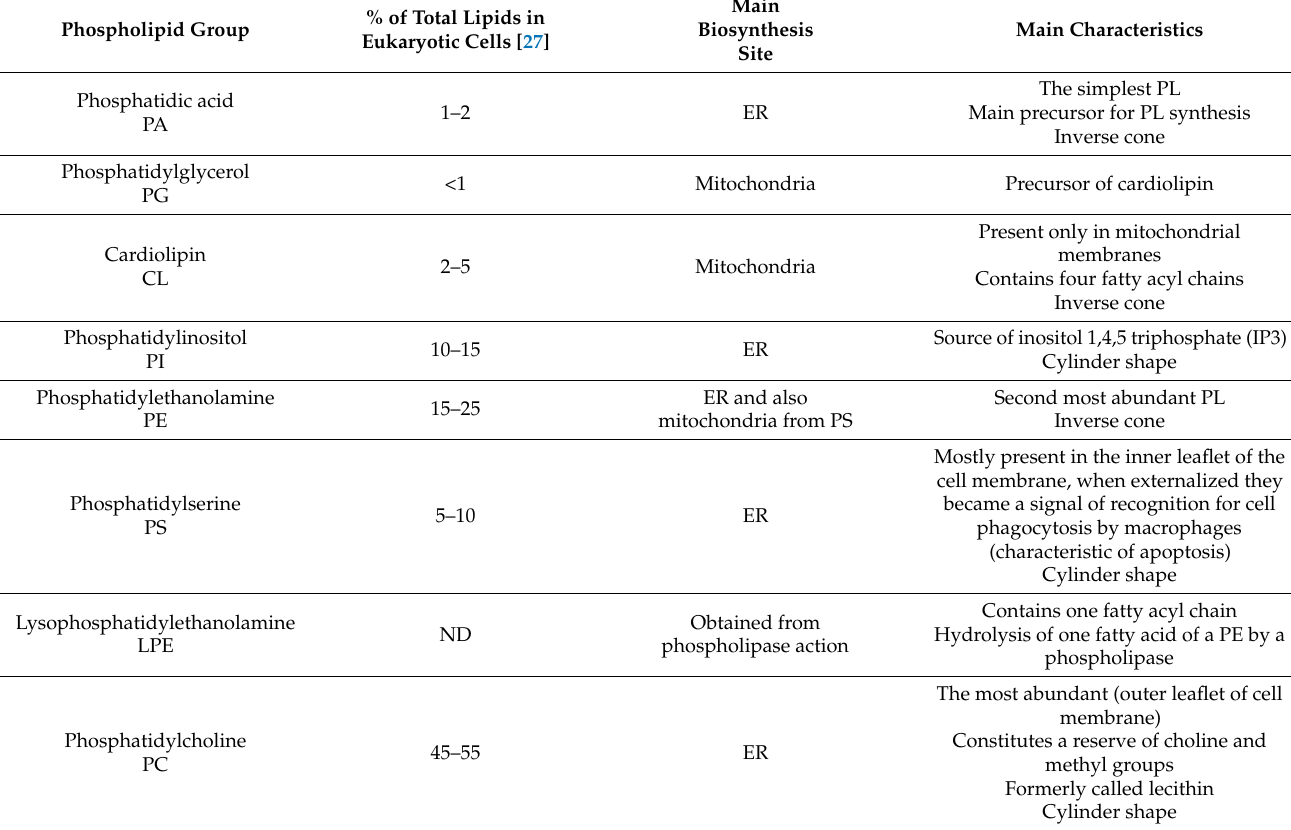
Table 2. Main characteristics of